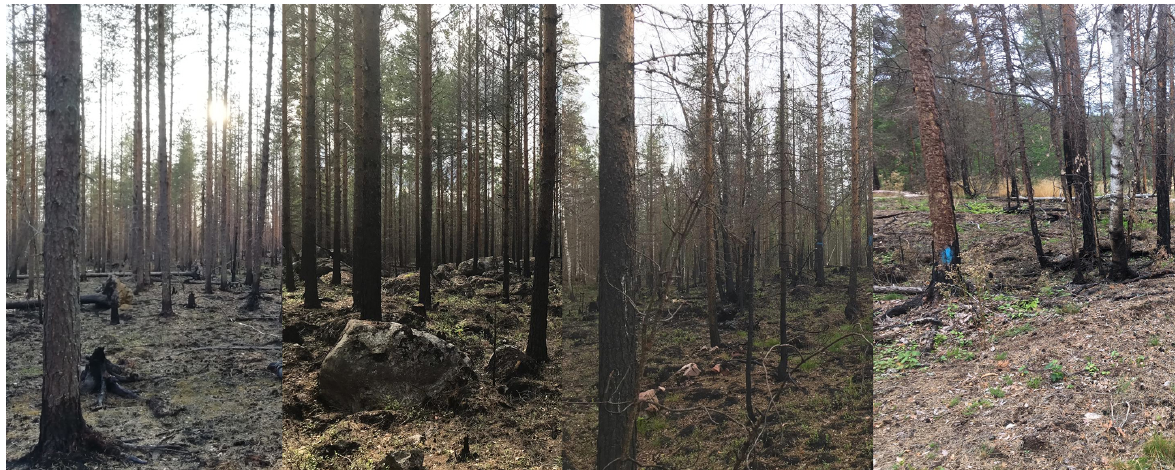
Figure 2. Field pictures from four separate burnt plots taken approximately 1 year after fire. Trees show charring of boles and enhanced exposure of roots due to fire-reduced organic layer height. Upon a surface char layer are new litter additions composed of mostly needles. Patchy regrowth of understory was present in many